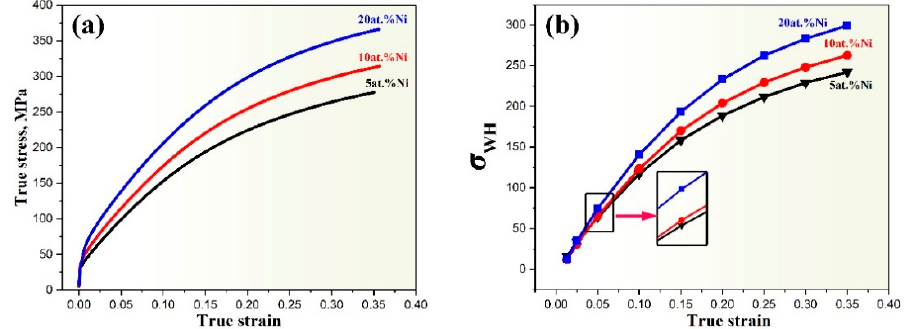
Figure 2. Mechanical properties of Cu–Ni alloys under uniaxial compression. ( a ) True stress–strain curves; ( b ) the distribution of the σ WH of Cu–Ni alloys at different strains.